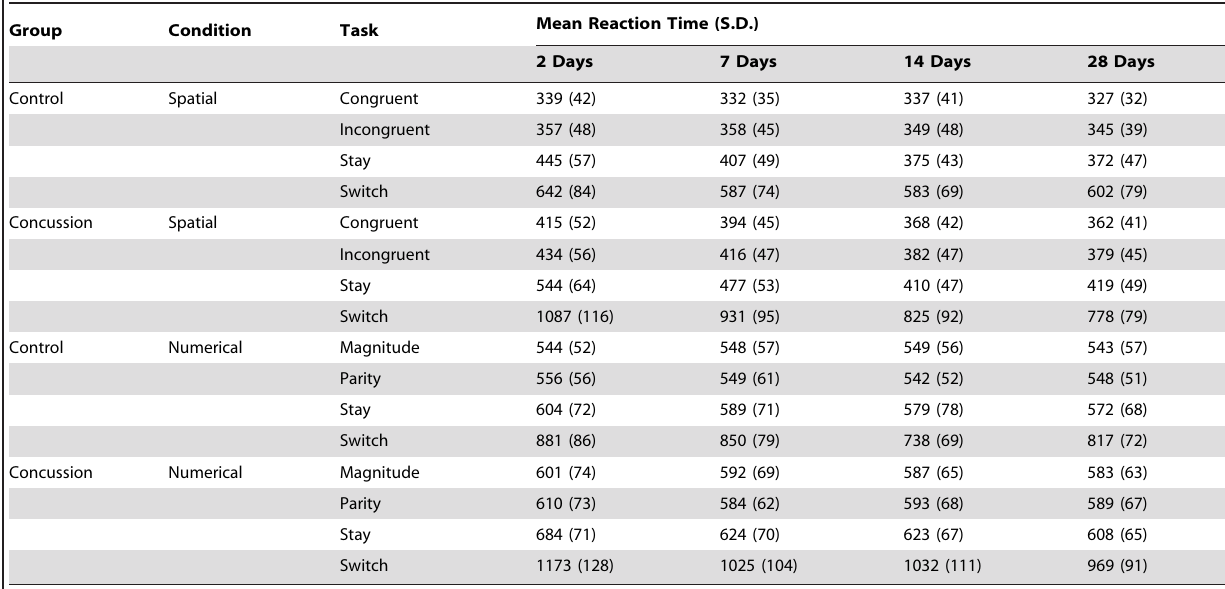
Table 2. Reaction times (ms).